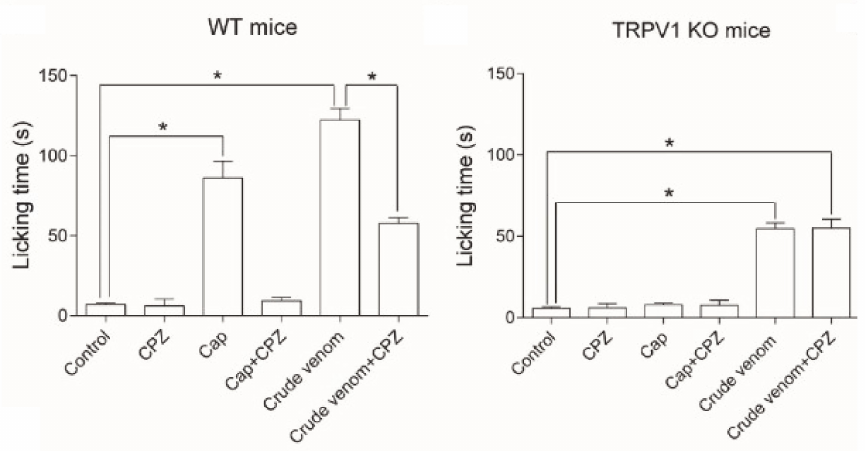
Figure 6. The TRPV1 antagonist, capsazepine, could not completely eliminate the paw licking behavior. Paw licking duration was monitored by Yao et al. (2019) [43] using the following experimental conditions. (A) Ten microliters of saline (control), capsazepine (CPZ, 2 mM), capsaicin (Cap, 500 µ M), crude venom (100 µ g / mL), capsaicin (500 µ M) / capsazepine (2 mM) mixture, and crude venom (100 µ g / mL) / capsazepine (2 mM) mixture injected into the left hind paw of WT mice. Two-sided t -test: *, p < 0.05; n = 6. (B) Mean durations of paw licking induced by 10 µ L of saline (control), capsazepine (2 mM), capsaicin (500 µ M), crude venom (100 µ g / mL), capsaicin (500 µ M) / capsazepine (2 mM) mixture, and crude venom (100 µ g / mL) / capsazepine (2 mM) mixture injected into the paw of TRPV1 KO mice. The figure was copied with permission from